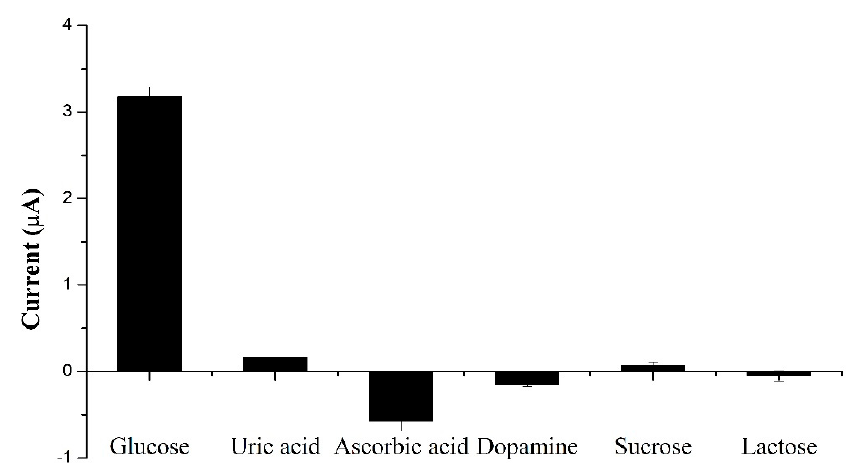
Figure 8. Amperometric response of the proposed sensor to interfering species.